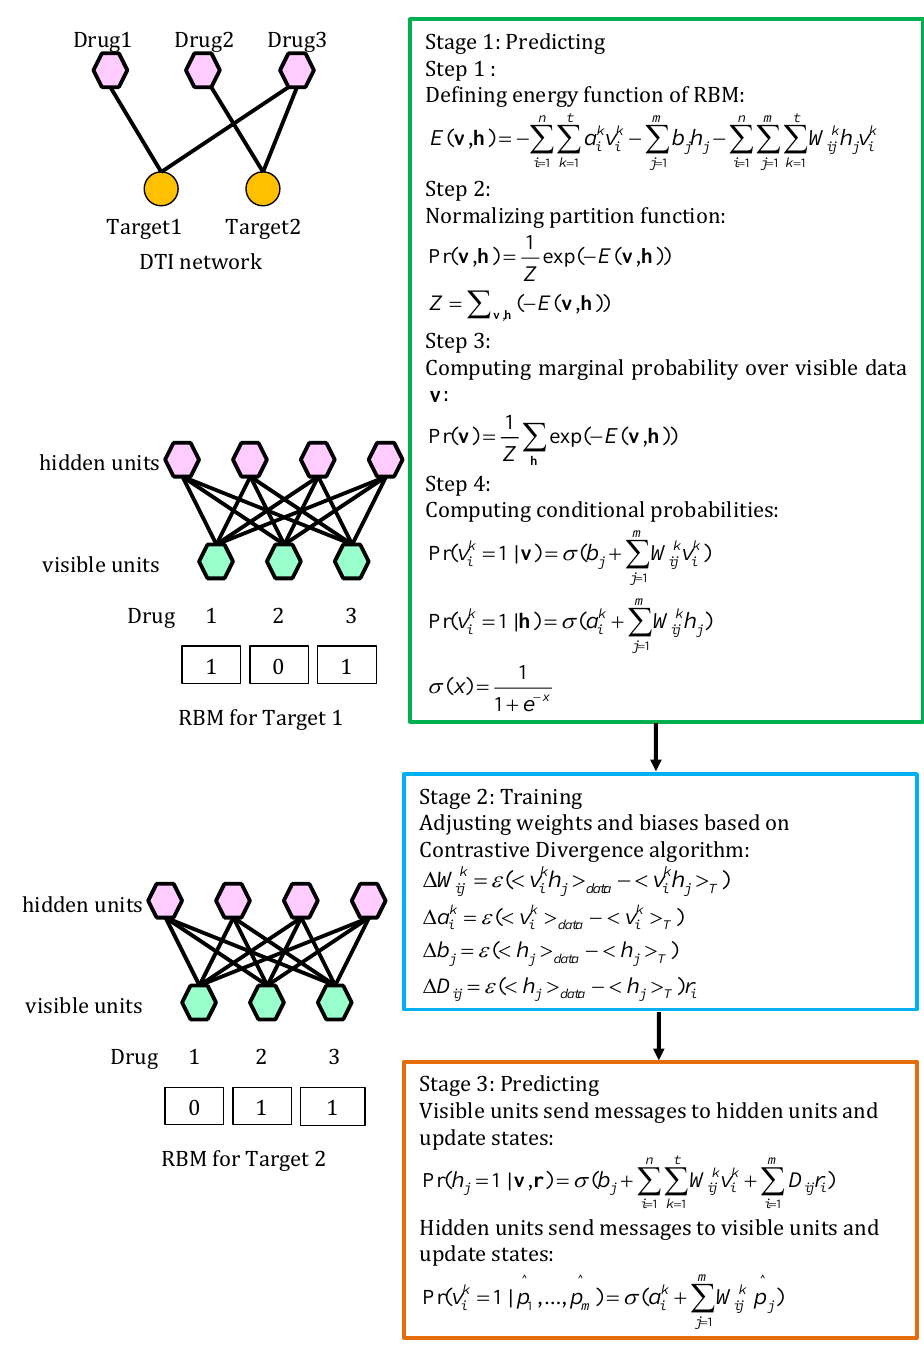
Figure 13. The flowchart of restricted Boltzmann machine